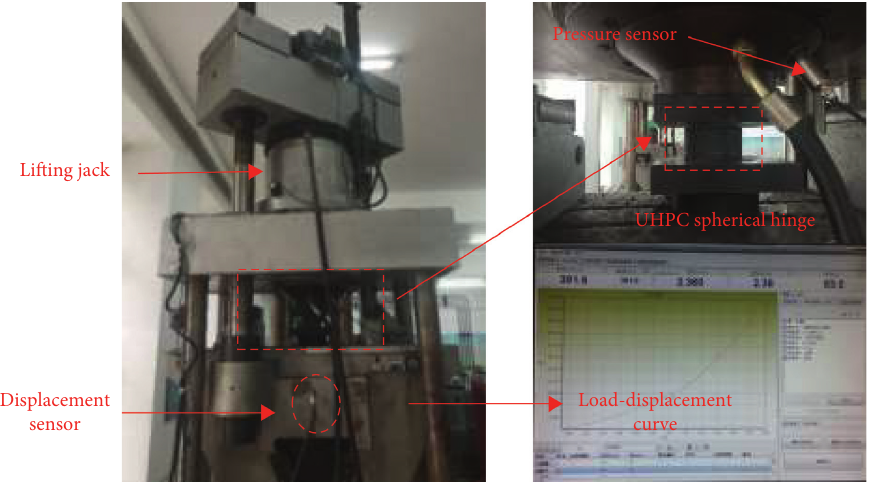
Figure 7: Test loading